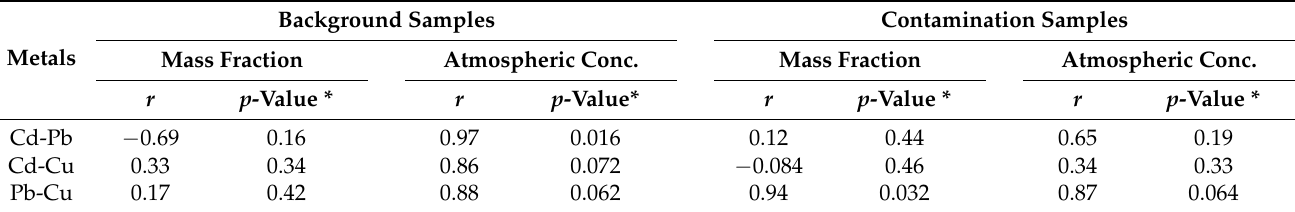
Table 4. Correlation coefficients ( r ) and significance ( p -value) between metal contents in samples of the background series (CS-2, AT1-2, AT1-3, AT2-2) and in those affected by the station activities (CS-1, CS-3, AT1-1, AT2-1). One-tailed t -test is used since the interest is for r > 0.